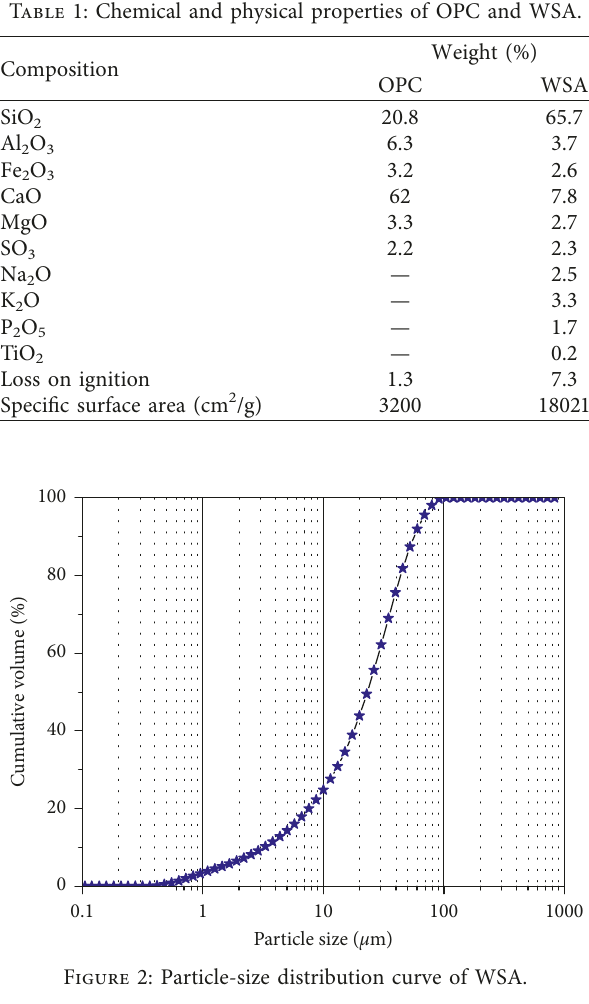
Figure 3: X-ray diffraction of WSA particles.